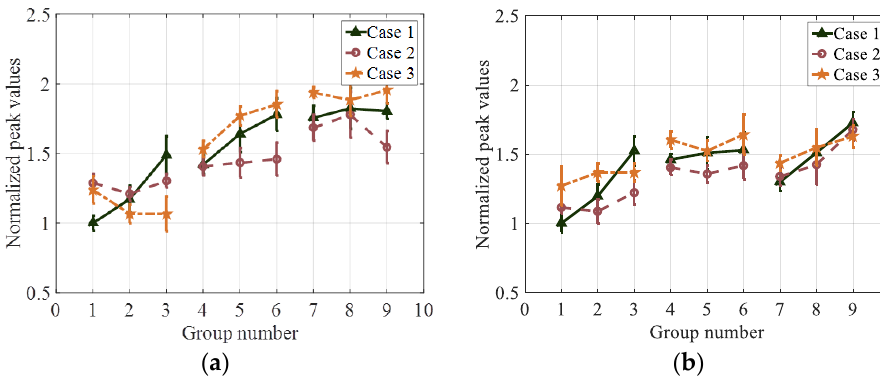
Figure 10. The influence of the cutting direction on the milling forces for the two workpieces: ( a ) the workpiece built with the SSR of 90°, ( b ) the workpiece built with the SSR of 67°.